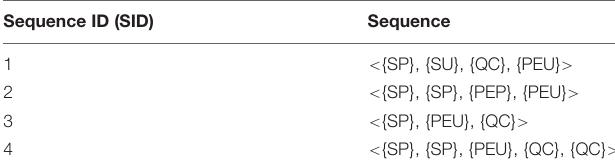
TABLE 3 | An example sequence